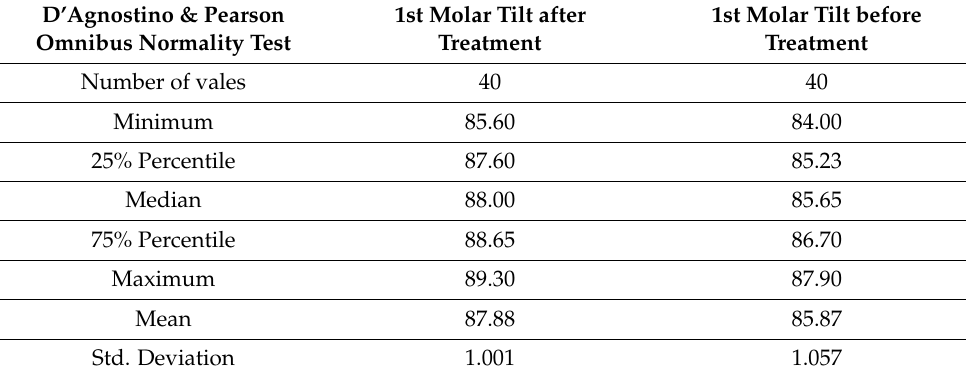
Table 4. Changes at the first molar position after